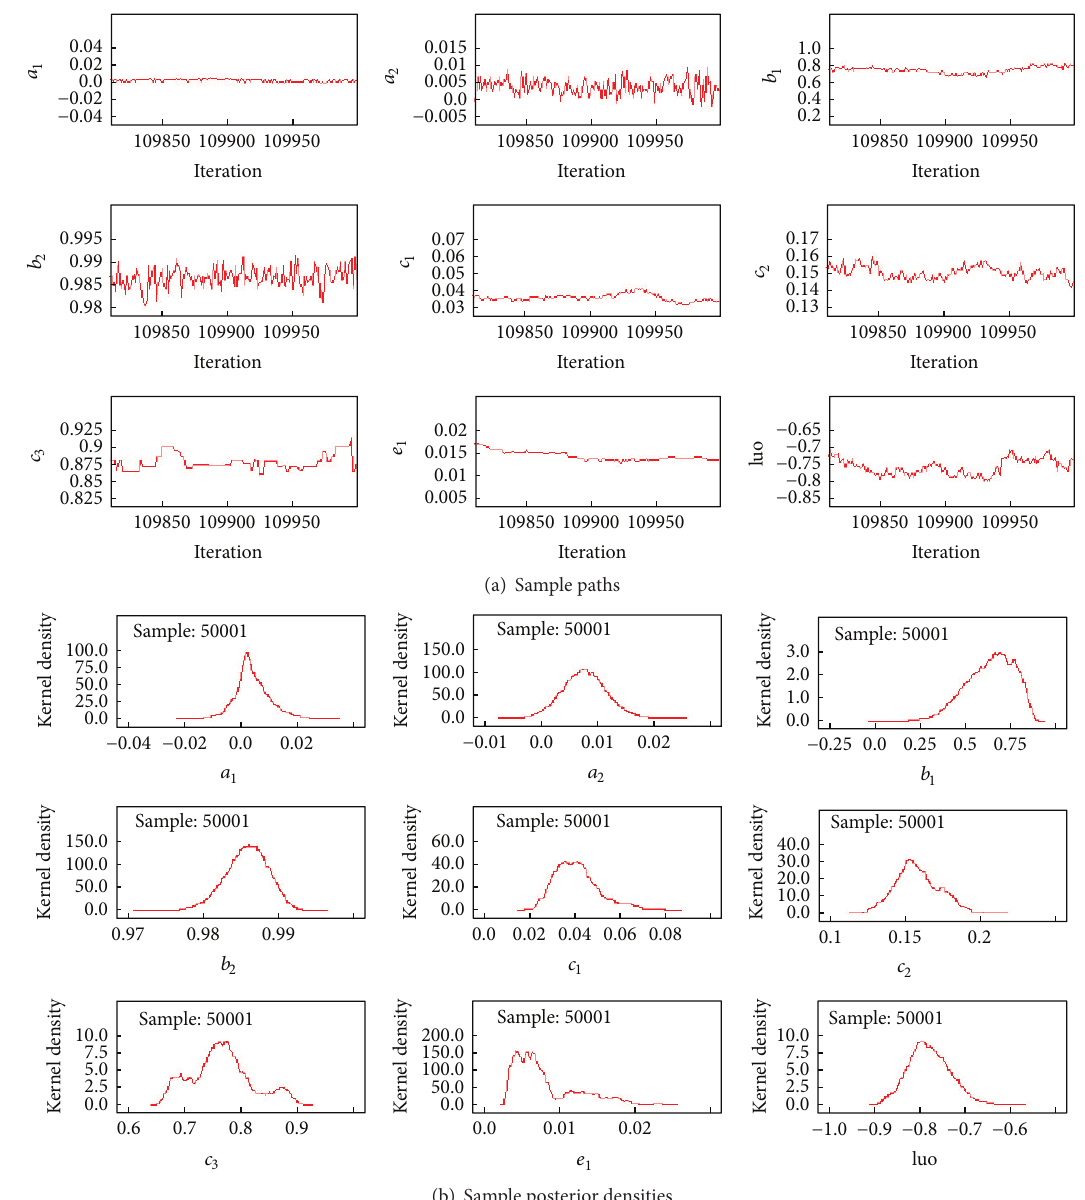
(b) Sample posterior densities Figure 8: Sample path and density estimates for